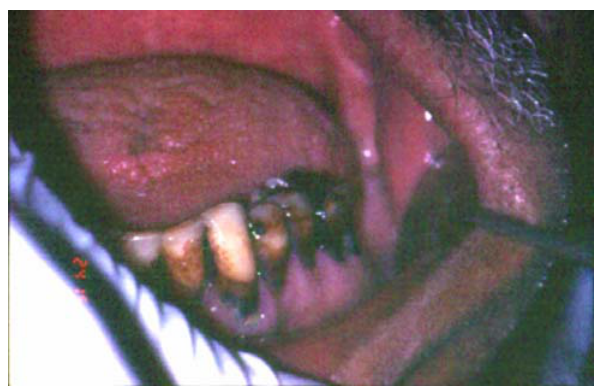
Figure 1: Gum recession with extrinsic staining affecting the posterior teeth where this individual used to smoke during the qat sessions Out of 972 non-chewers 116(12%) had periodontal pocketing of different depths, 473 (48.7%) cases had gingival bleeding and 18 (1.9%) had gum recession. On the other hand, out of 1528 chewers, 468 (31.8%) had periodontal pockets, 1214 (79.5%) with gum bleeding and 98 (6.4%) had gum recession. These differences were statistically significant (p<0.0000001) (Tables 1 and